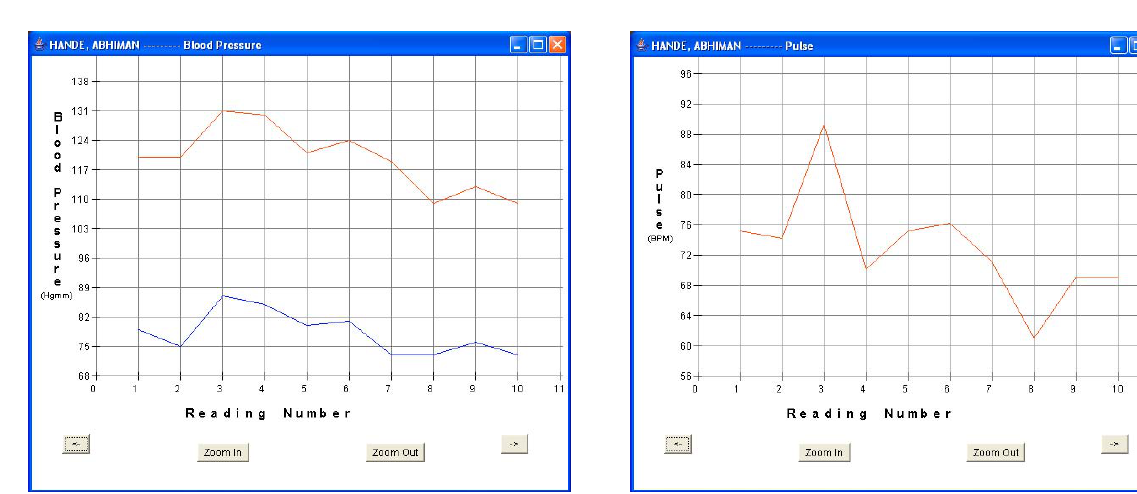
Figure 8a. Patient 1 BP data. Figure 8b. Patient 1 pulse data.